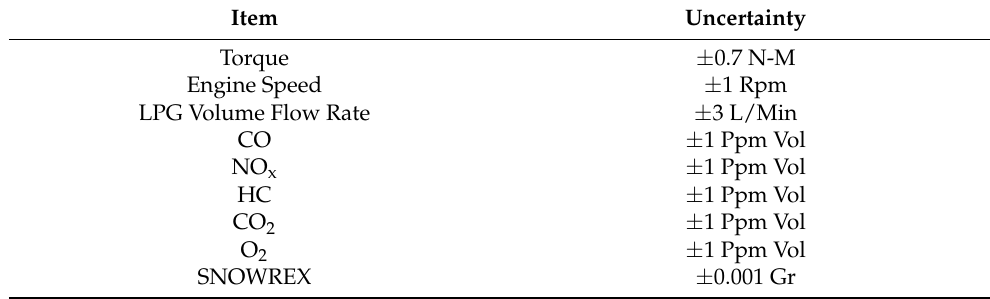
Table 2. Uncertainties of